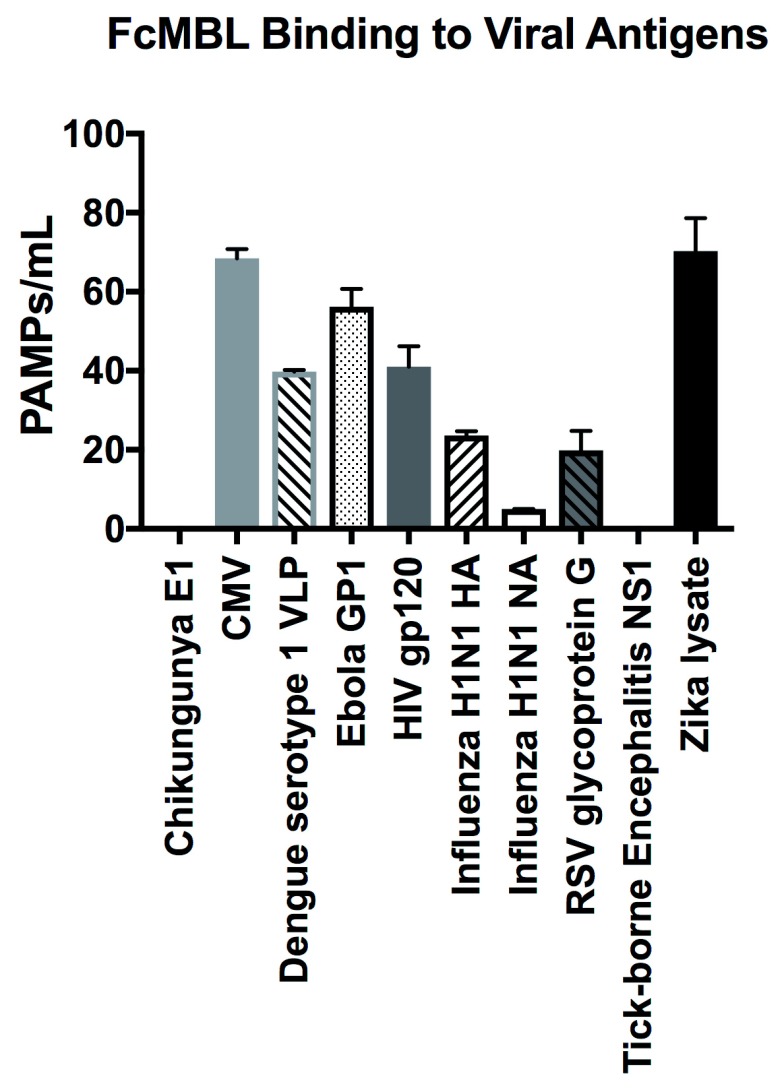
FcMBL binding to viral antigens.FcMBL ELLecSA screening of Chikungunya E1 (3.0 µg/ml), Cytomegalovirus (CMV) (10
7 PFU), Dengue serotype 1 VLP (0.36 µg/ml), Human immunodeficiency virus (HIV) gp120 (0.1 µg/ml), Ebola GP1 (0.2 µg/ml), Influenza H1N1 HA (0.1 µg/ml), Influenza H1N1 NA (1 µg/ml), Respiratory syncytial virus (RSV) glycoprotein g (10.0 µg/ml), Tick-borne Encephalitis NS1 (5 µg/ml), and Zika lysate (0.24 µg/ml).